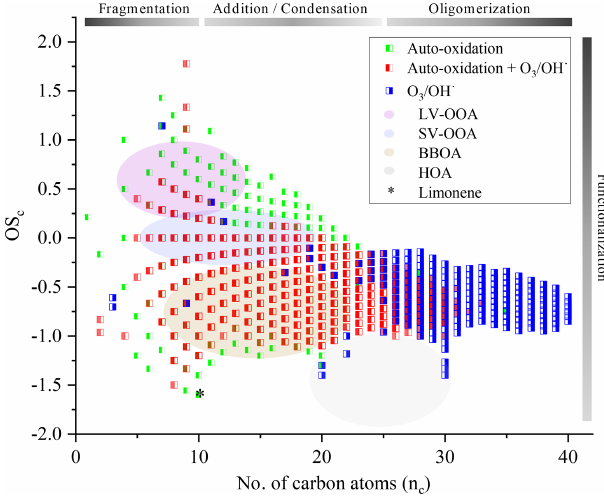
Figure 8. Representation in the OS c – n c space of all the chemical formulae considered in this study and analysis of the degree of oxi-